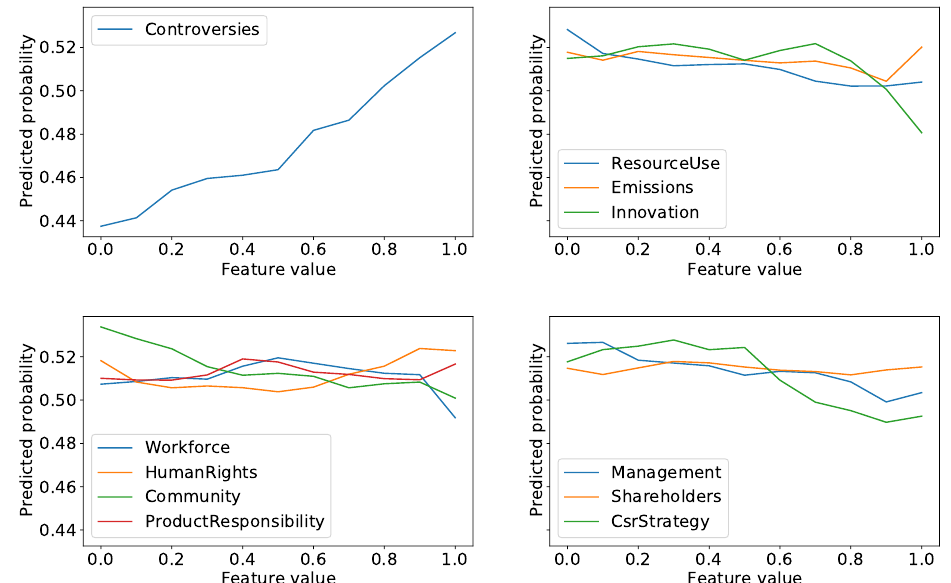
Figure 11. Marginal effect of each ESG feature on the predicted probability of having a positive return.